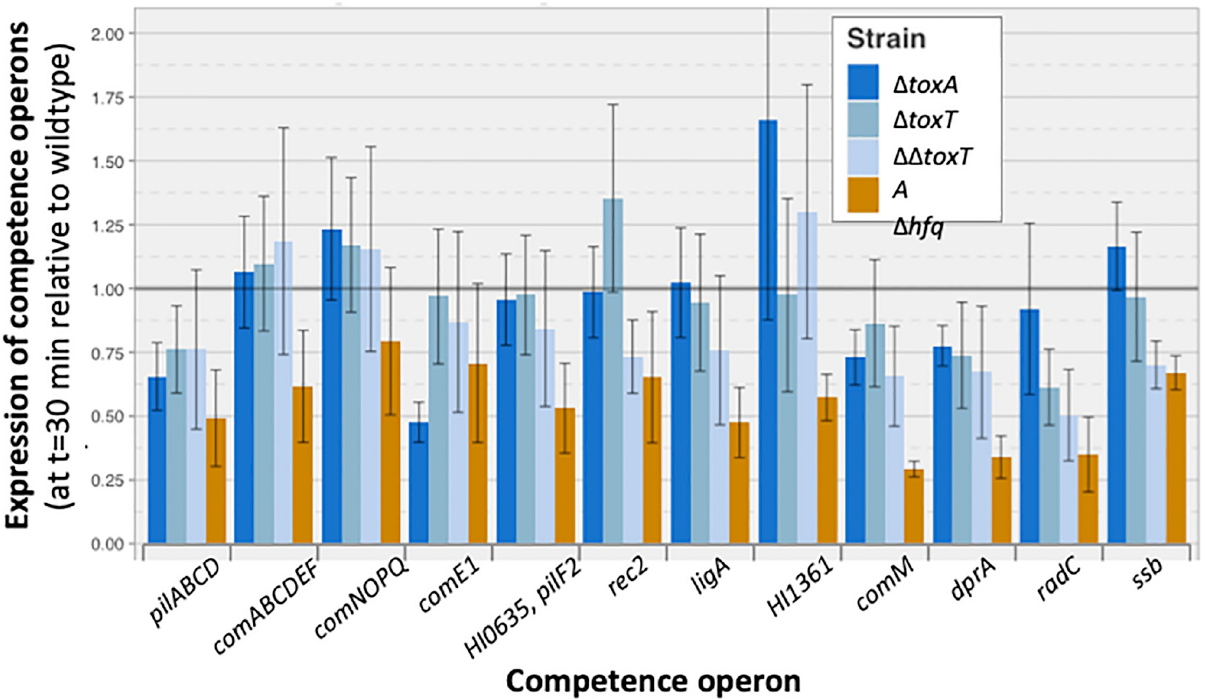
Fig 9. RNA-seq analysis of H . influenzae toxTA effects on competence-operon transcript levels. Bars show the relative transcript levels (as FPKM) of competence operons in four different mutants after 30 minutes of competence induction: Δ toxA : dark blue, Δ toxT : blue, Δ toxTA : light blue, Δ hfq : brown. Transcript levels of each operon are relative to levels in wildtype cells at the same time point (grey horizontal bar). Error bars indicate standard errors of samples from three replicate cultures.